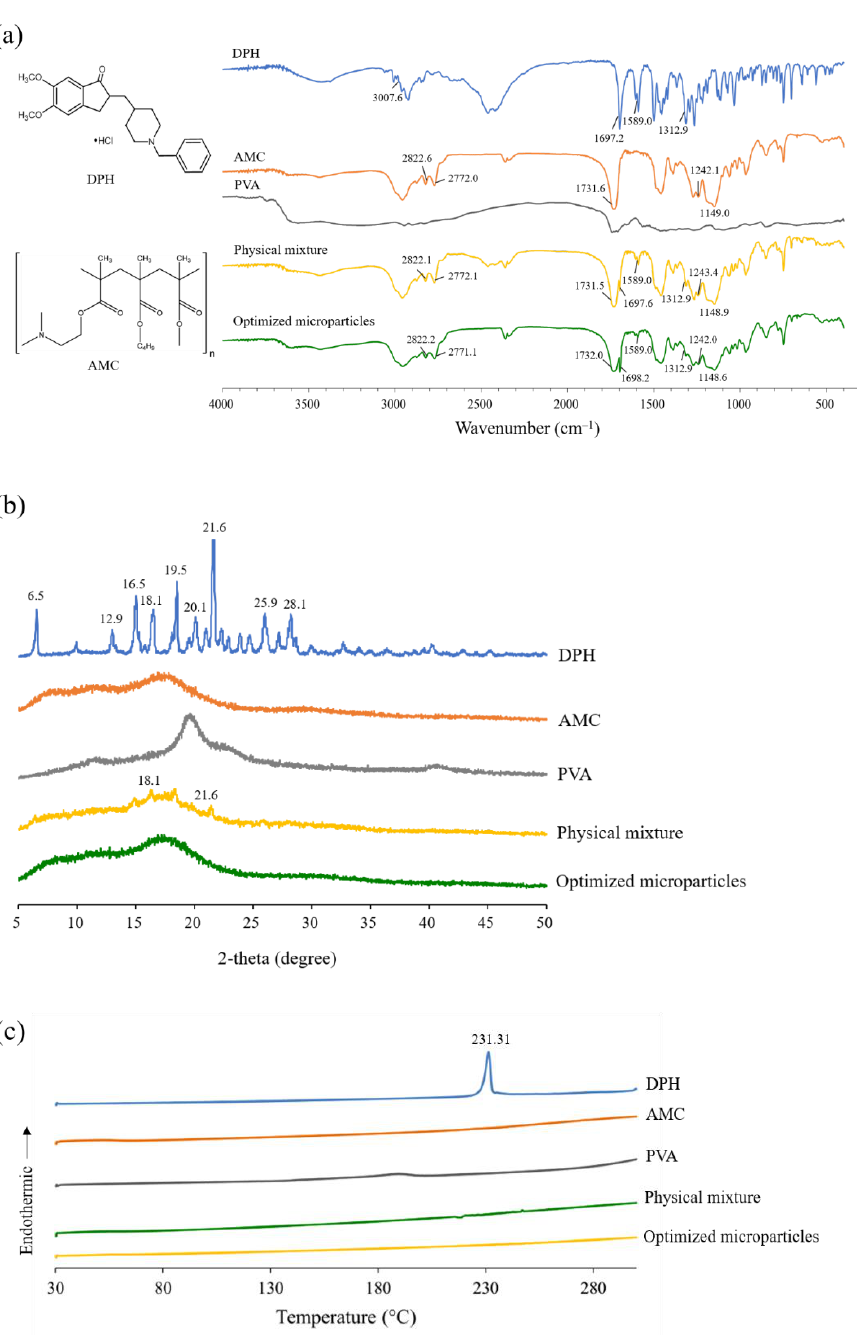
Figure 6. ( a ) FTIR spectra, ( b ) PXRD patterns, and ( c ) DSC thermograms of DPH, AMC, PVA, physical mixture, and optimized microparticles. Table 8. Physical properties of ODTs.